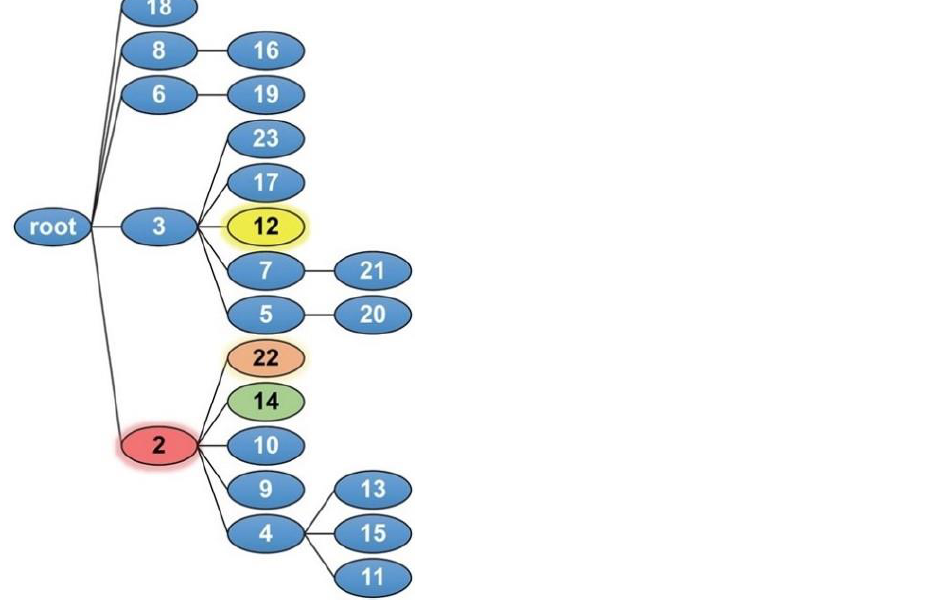
Figure 4. BPPS defined Sema domain hierarchy. Sema4A, Sema4D, and PlexinB1 correspond to nodes 14, 22, and 12, respectively. 14, 22, and 12,